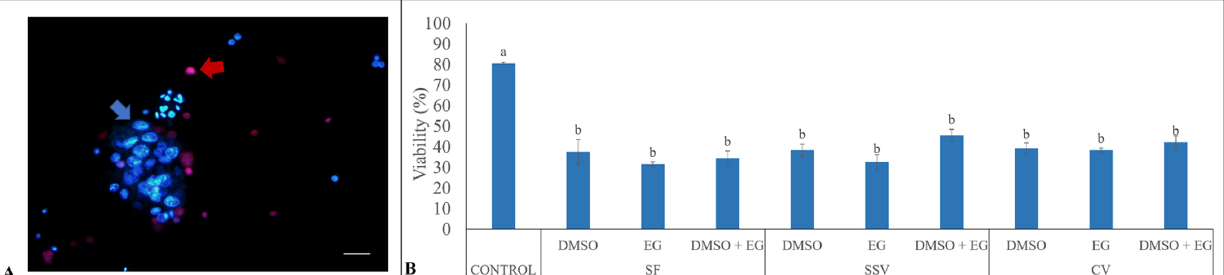
Figure 2. Evaluations of cell viability in testicular tissues from adult red-rumped agoutis (n = 5 males) after different cryopreservation treatments. ( A ) Representative picture of testicular cell viability evaluated by fluorescent probes. Blue arrow indicates cells in suspension stained with Hoechst 33342; red arrow indicates non-viable cells in the same suspension stained with propidium iodide. ( B ) Average proportions (mean ± SEM) of viable cells in testicular tissues exposed to different treatments (slow freezing, SF; conventional vitrification, CV; and solid-surface vitrification, SSV) and different cryoprotectants: dimethyl sulfoxide (DMSO), ethylene glycol (EG), and DMSO + EG. Scale bar: 20 µm. a,b Different lowercase letters above bars indicate differences among treatments ( p < 0.05).